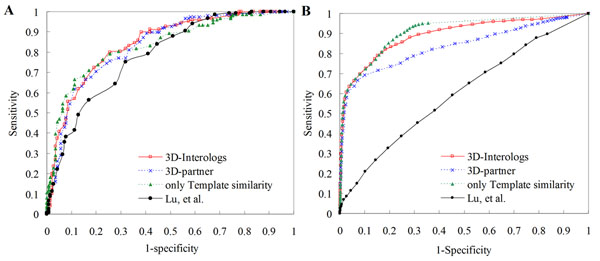
The ROC curves of the 3D-interologs for protein-protein interactions. The 3D-interologs search results on (A) S. cerevisiae and (B) 549 species (Intger8) using the data set NR-563 (563 dimer-complex structures) by applying four scoring functions, including 3D-interologs (red), 3D-partner (blue), only template similarity (Esim, green) and one matrix (black) proposed by Lu, et al.